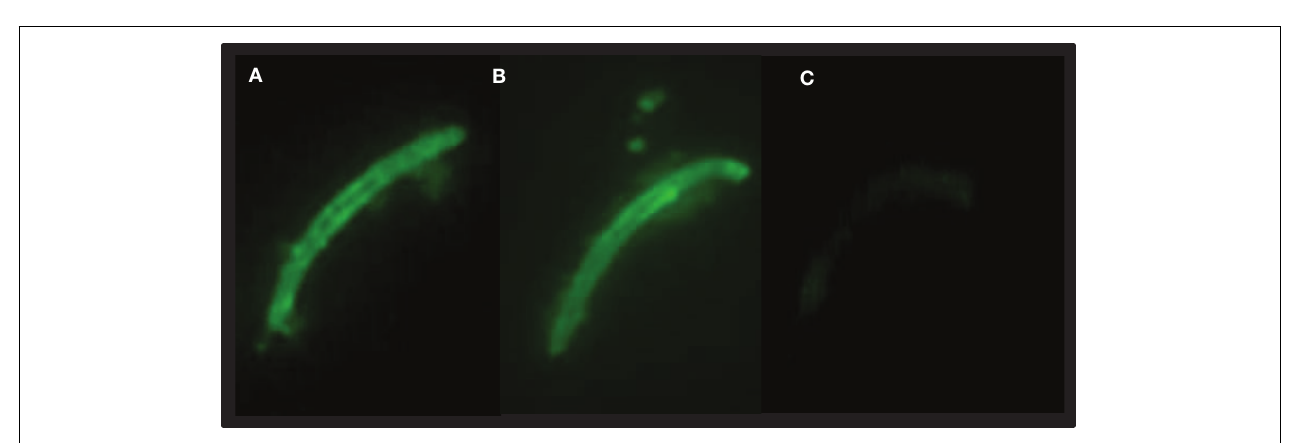
immunized with empty GeMI-Vax did not react with sporozoites (C) . Representative images were taken at 1,000 × magnification, staining at 1:10,000